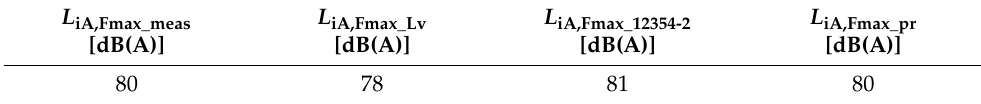
Figure 19. Measured and predicted energy average maximum impact sound pressure level with rubber ball. Table 6. Weighted sound pressure